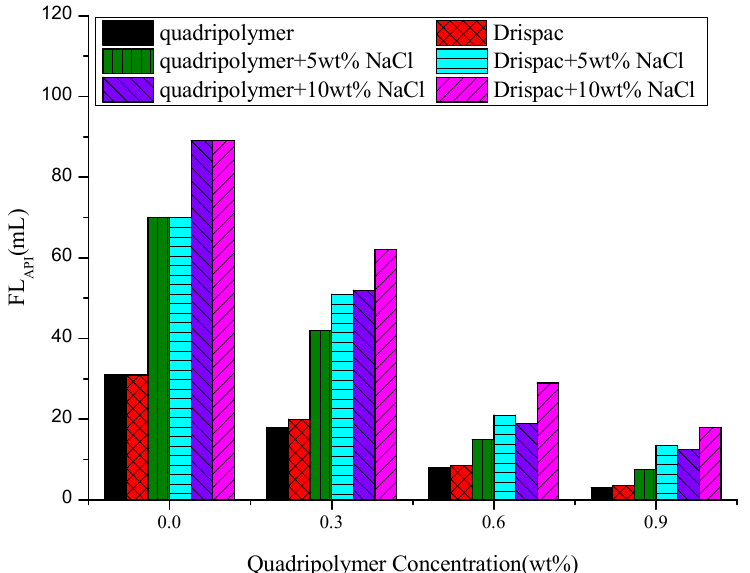
Figure 5. Effect of salinity and polymers on filtration property of bentonite-free drilling fluid.